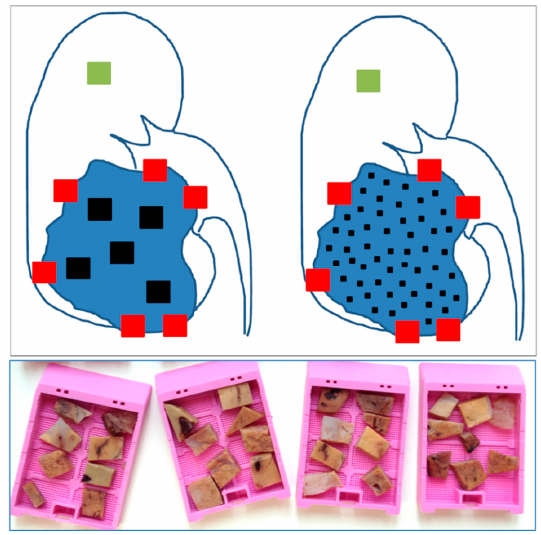
Figure 1. Schematic representation of routine and multisite tumor sampling (MSTS) concepts in renal tumors. The scheme shows the routine sampling ( left ) and the MSTS ( right ). Red cubes represent samples at the edges of the tumor (renal sinus, extrarenal extension and interface between non-tumor and tumor kidney) to detect tumor invasion at these levels. The green cube represents the preceptive sample of normal kidney. Black cubes represent the tumor sampling in both strategies making use of the same number of blocks (up to 8 small fragments can be introduced in one cassette in MSTS). Cassettes containing tumor tissue fragments from MSTS are shown at the bottom of the picture.